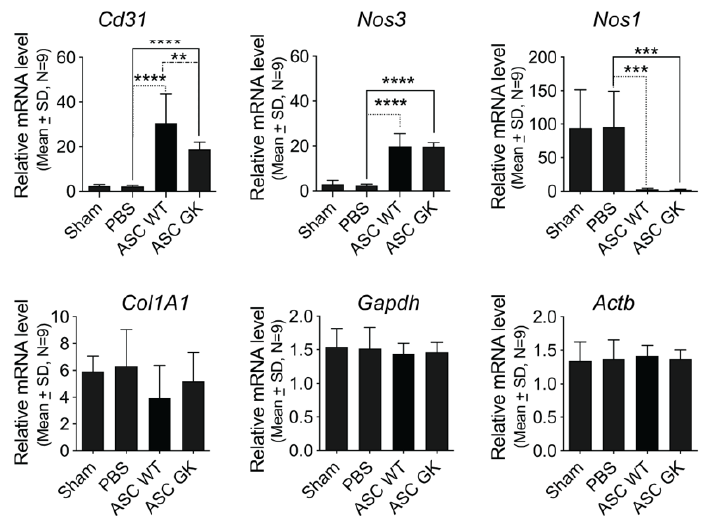
Figure 4. ASCs derived from both WT and GK rats induce endothelial gene expression in vivo: mRNA expression of endothelial markers Cd31 (Pecam1 ) and Nos3 ( eNOS ), neuronal marker Nos1 ( nNOS ) and fibrotic marker Col1a1 ( Pro-collagen 1 ) were analyzed by qRT-PCR of corpus cavernous tissue from rats as indicated by treatment group (n = 9 in each). All data were normalized to two stably expressed reference genes, Gapdh and Actb ( β -actin ). Data is represented as mean ± SD, and statistical significance was tested by ordinary one-way ANOVA with Tukey’s multiple comparison test. ** p < 0.01, *** p < 0.001, **** p < 0.0001.